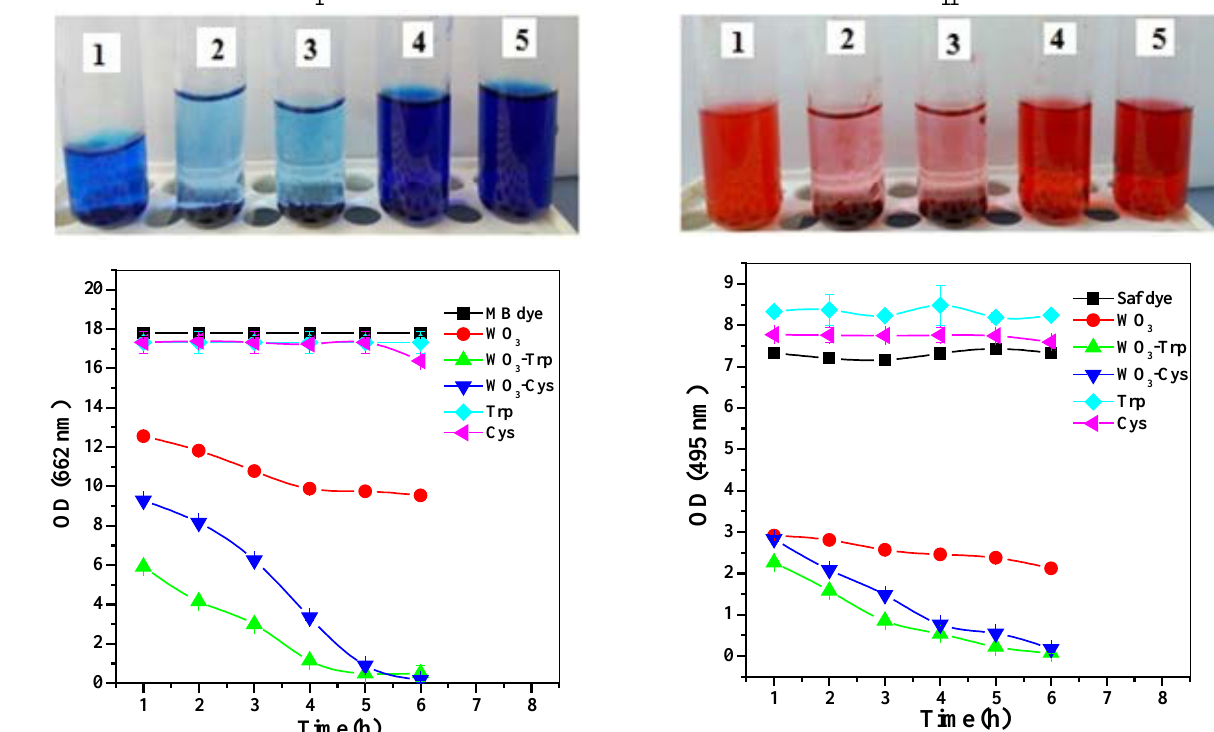
Figure 4. Photographs ( A ) and decolorization percentages ( B ) of dye removal rate for methylene blue (I) and safranin (II) by the prepared modified WO 3 NPs with Trp and Cys. Methylene blue and safranin at a concentration of 100 mg/mL were decolorized by WO 3 NPs (1), the modified WO 3 -Trp (2), WO 3 -Cys (3), Trp (4), and Cys (5) for 6 h. The data are presented as mean ± SE and represent the average values from three experiments ( n = 3).